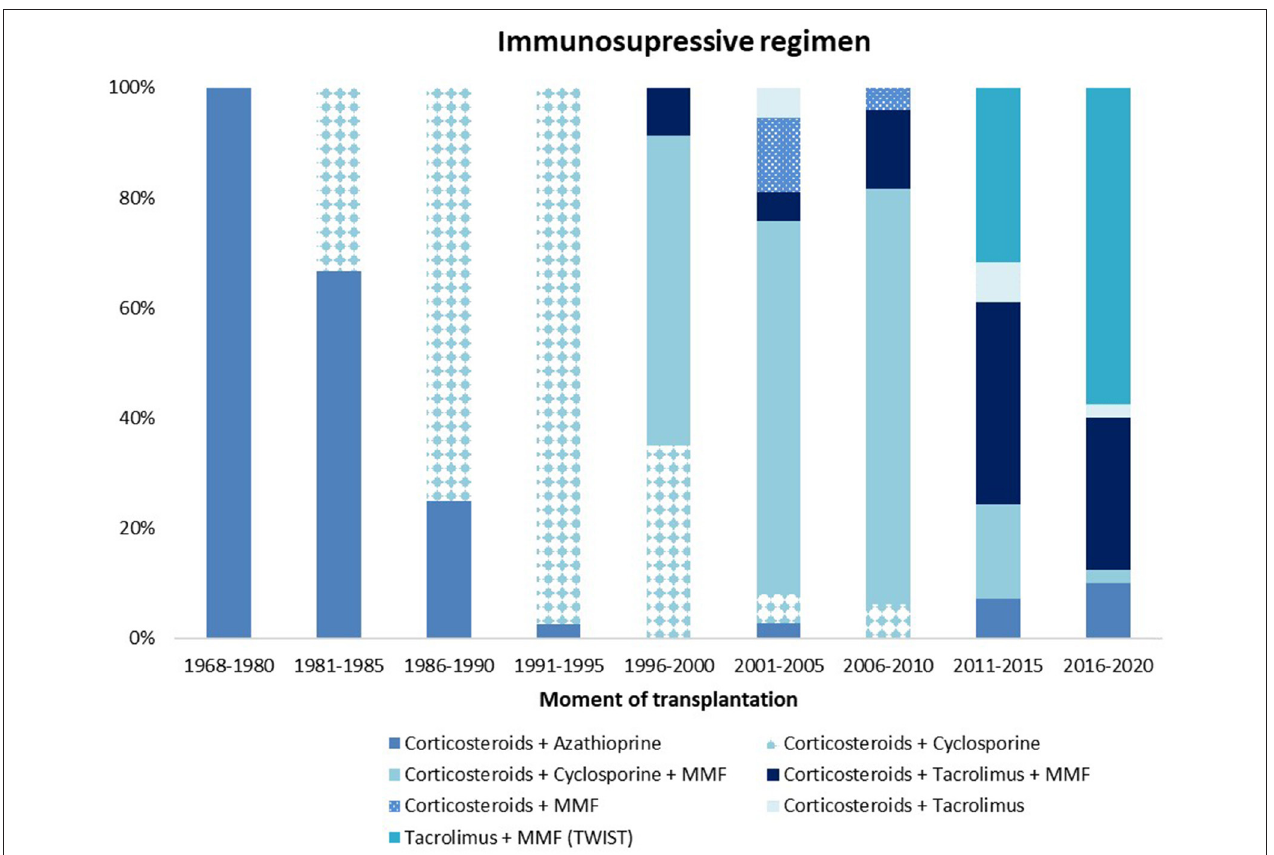
FIGURE 5 | Immunosuppressive maintenance regimen at 3 months after transplantation. MMF, mycophenolate